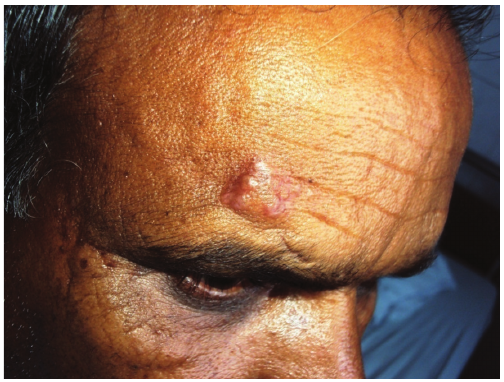
Figure 1: Scar enlarged on the forehead.